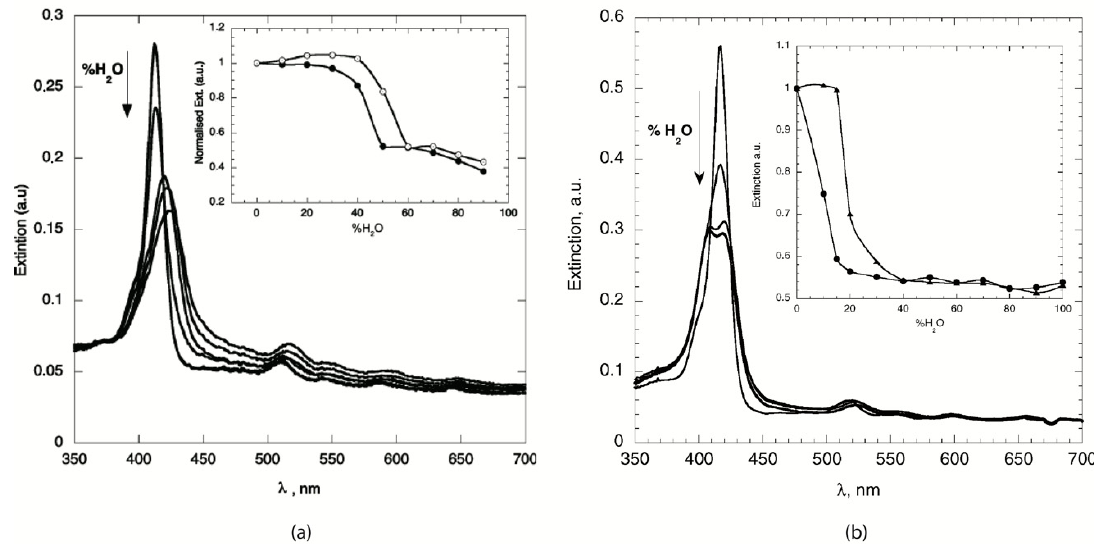
Figure 2. Spectral variations of glycoporphyrins increasing water proportion. ( a ) Porphyrin 2 (1.3 µ M) in CH 3 CN-H 2 O solvent mixtures. Inset: aggregation profiles for 1 (lower curve) and 2 (upper curve) 3.7 µ M, at T = 298 K; ( b ) porphyrin 4 (3.4 µ M) in EtOH / H 2 O mixtures. Inset: aggregation profiles for 3 (lower curve) and 4 (upper curve). Adapted with permissions from [34,35]. Copyright 2007 and 2008, The Royal Society of Chemistry.